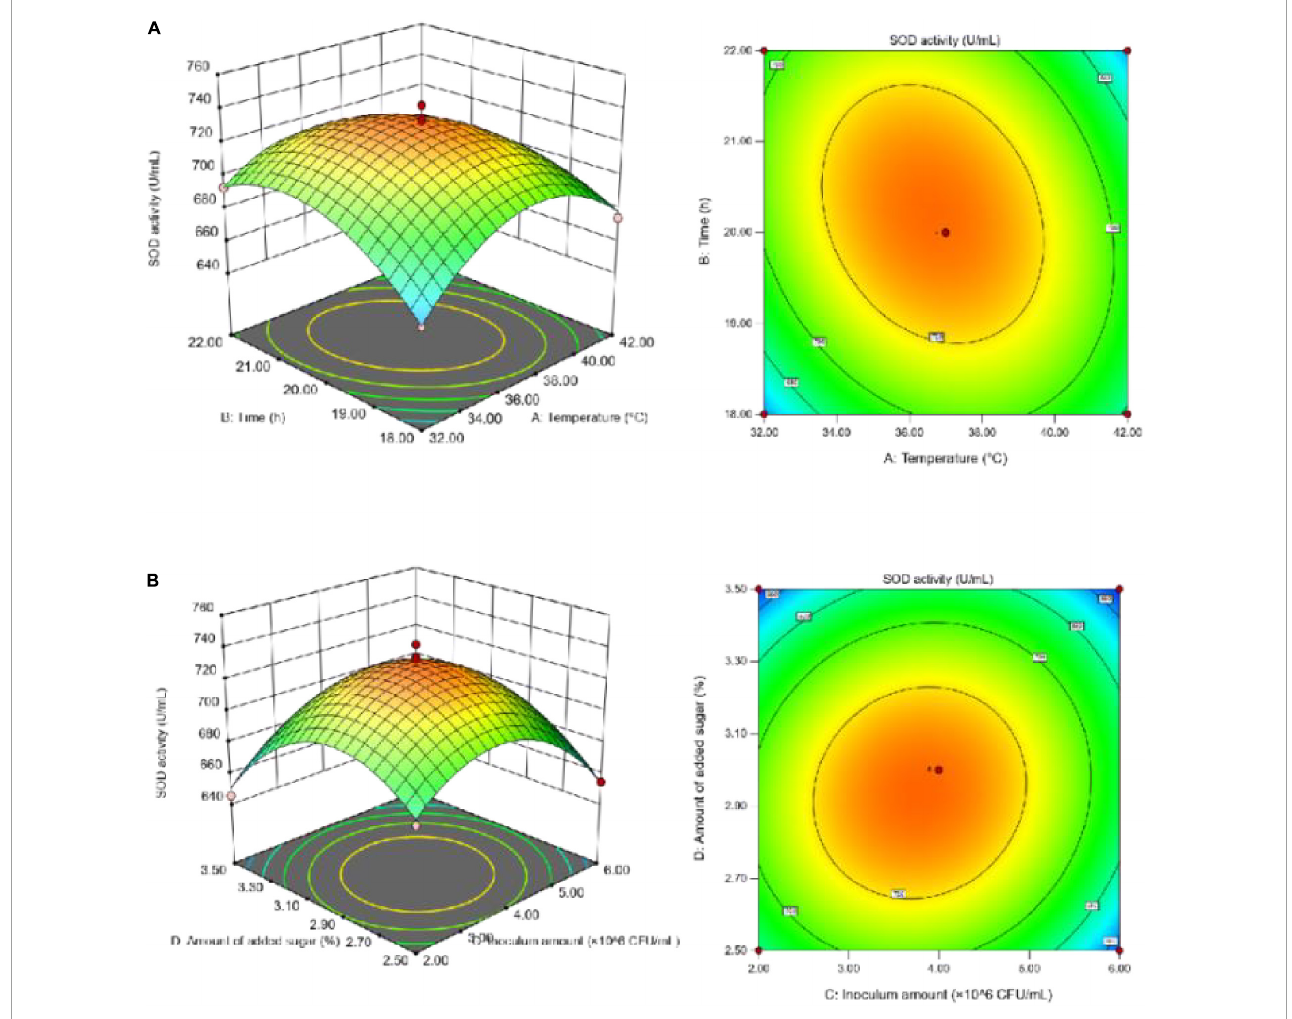
FIGURE3 (A) Effect of the interaction between fermentation temperature and fermentation time on SOD activity; (B) effect of the interaction between inoculum amount and sugar addition on SOD